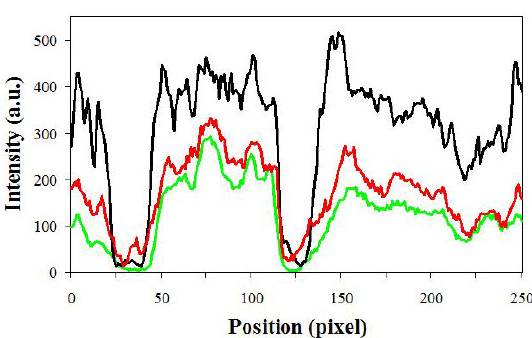
Figure 6. Intensity profiles along the vertical line indicated in Figure 5a showing the benefit of an optimized combination of SA and variable axicon (black line). Green line: original; red line: only SA.